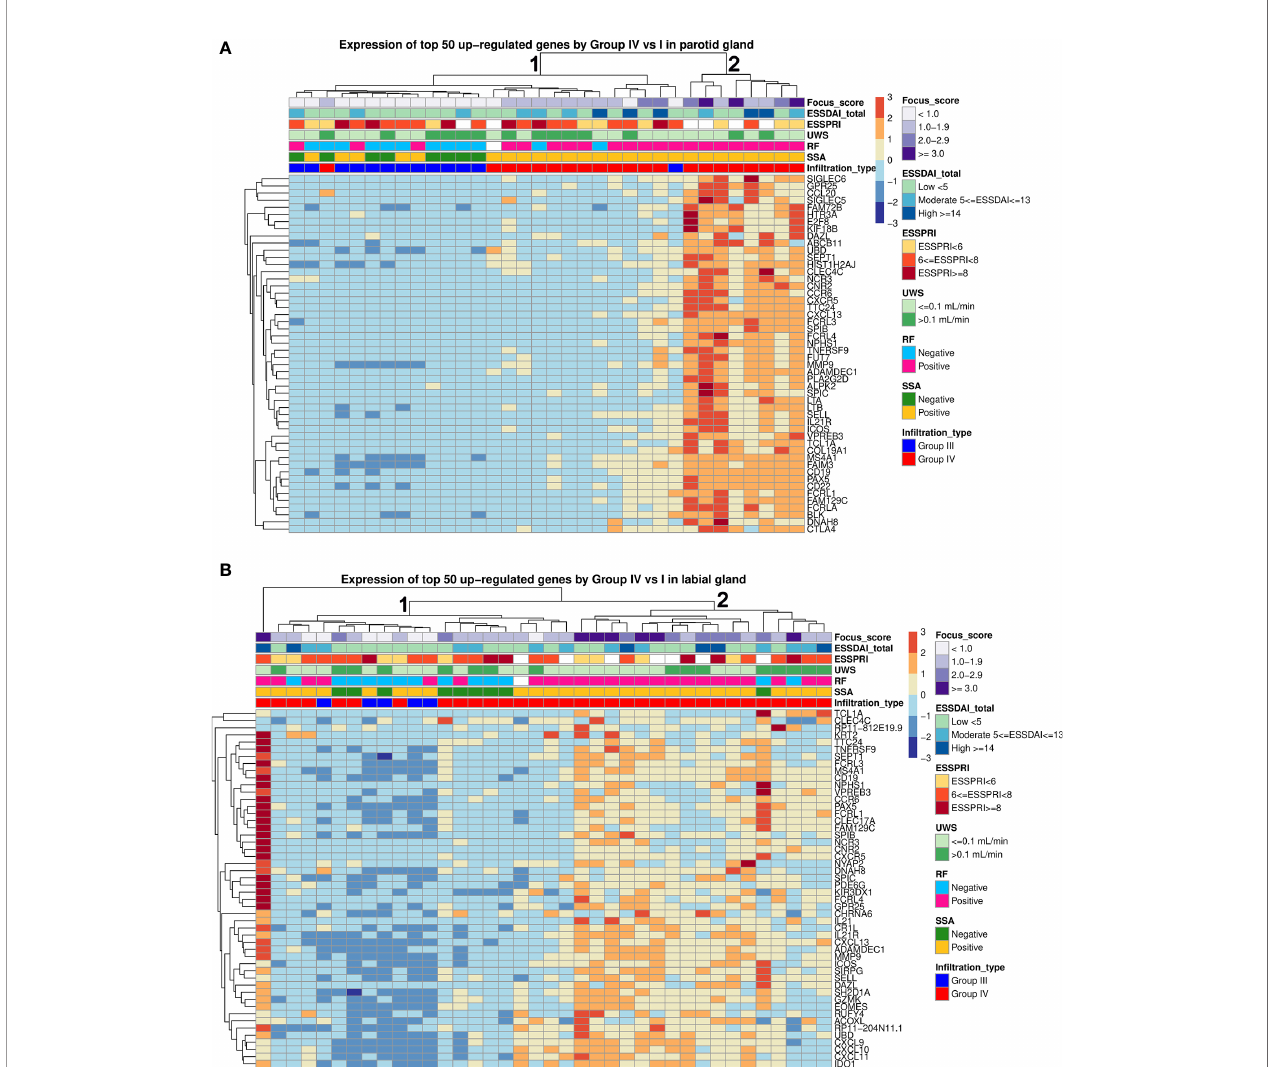
FIGURE 4 | Hierarchical clustering of parotid and labial gland samples from pSS patients. Unsupervised hierarchical clustering for all pSS patients was performed based on expression of the top 50 upregulated genes in each tissue. Each column represents a patient and each row represents a gene. The following clinical parameters were categorized and marked: Diagnostic biopsy focus score, EULAR Sjögren ’ s syndrome disease activity index (ESSDAI), EULAR Sjögren ’ s syndrome patient reported index (ESSPRI), unstimulated whole saliva (UWS) fl ow rates, rheumatoid factor (RF) positivity, anti-SSA positivity, histopathological